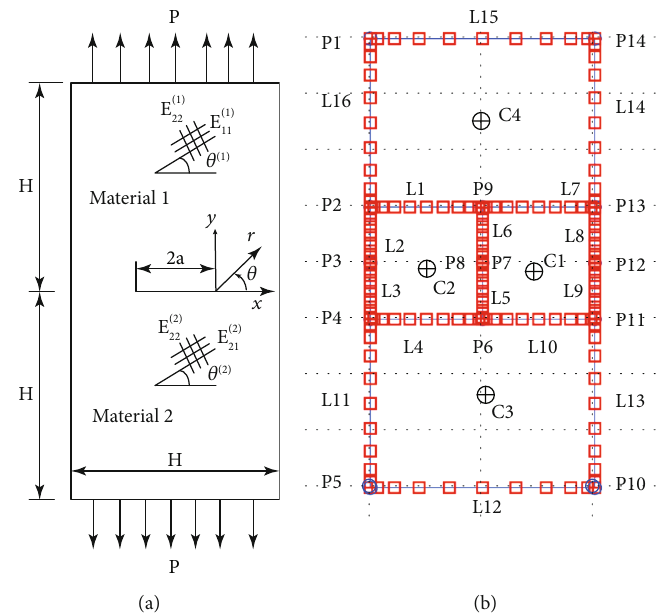
Figure 8: Rectangular bimaterial plate with an interfacial central crack [50]: (a) geometry; (b) mesh of 10th-order elements.